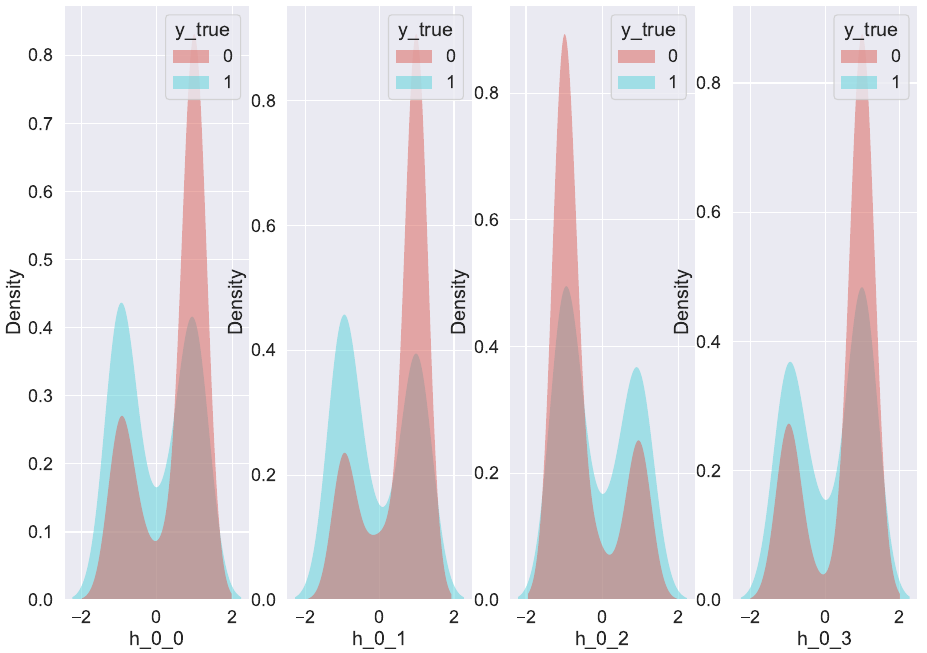
Figure A2. Histogram of binary activations for neurons in hidden layer zero in DL predictor for Prima Indians diabetes dataset. Each plot shows the activation density function per neuron discriminated by class (class 0 is shown in red, and class 1 is shown in